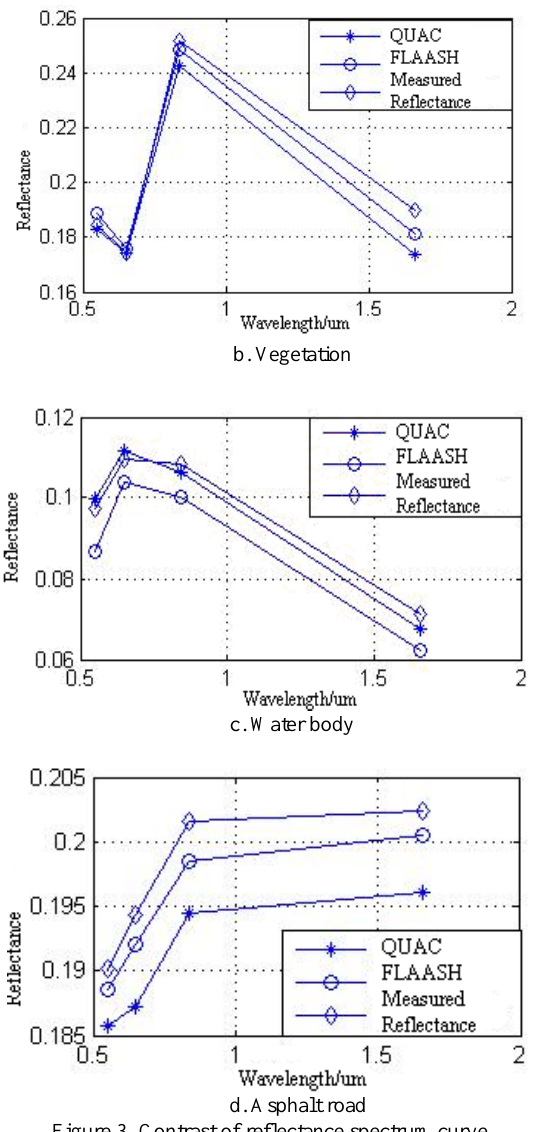
Figure 3. Contrast of reflectance spectrum curve As the fourth band of SPOT-5 is beyond the band scope of wild radiometer, in order to ensure the integrity and aesthetics of the comparison chart, during the resampling process of measured spectral reflectance curves, the reflectance of the part (the fourth band) beyond the band scope shall be given man-made based on past experience and trends of the curve, thus comparative analysis mainly focuses on comparing the differences of the first three bands. We can conclude from the figure that the measured reflectance curve of the first three bands is more similar to the curve after the Model FLAASH atmospheric correction.